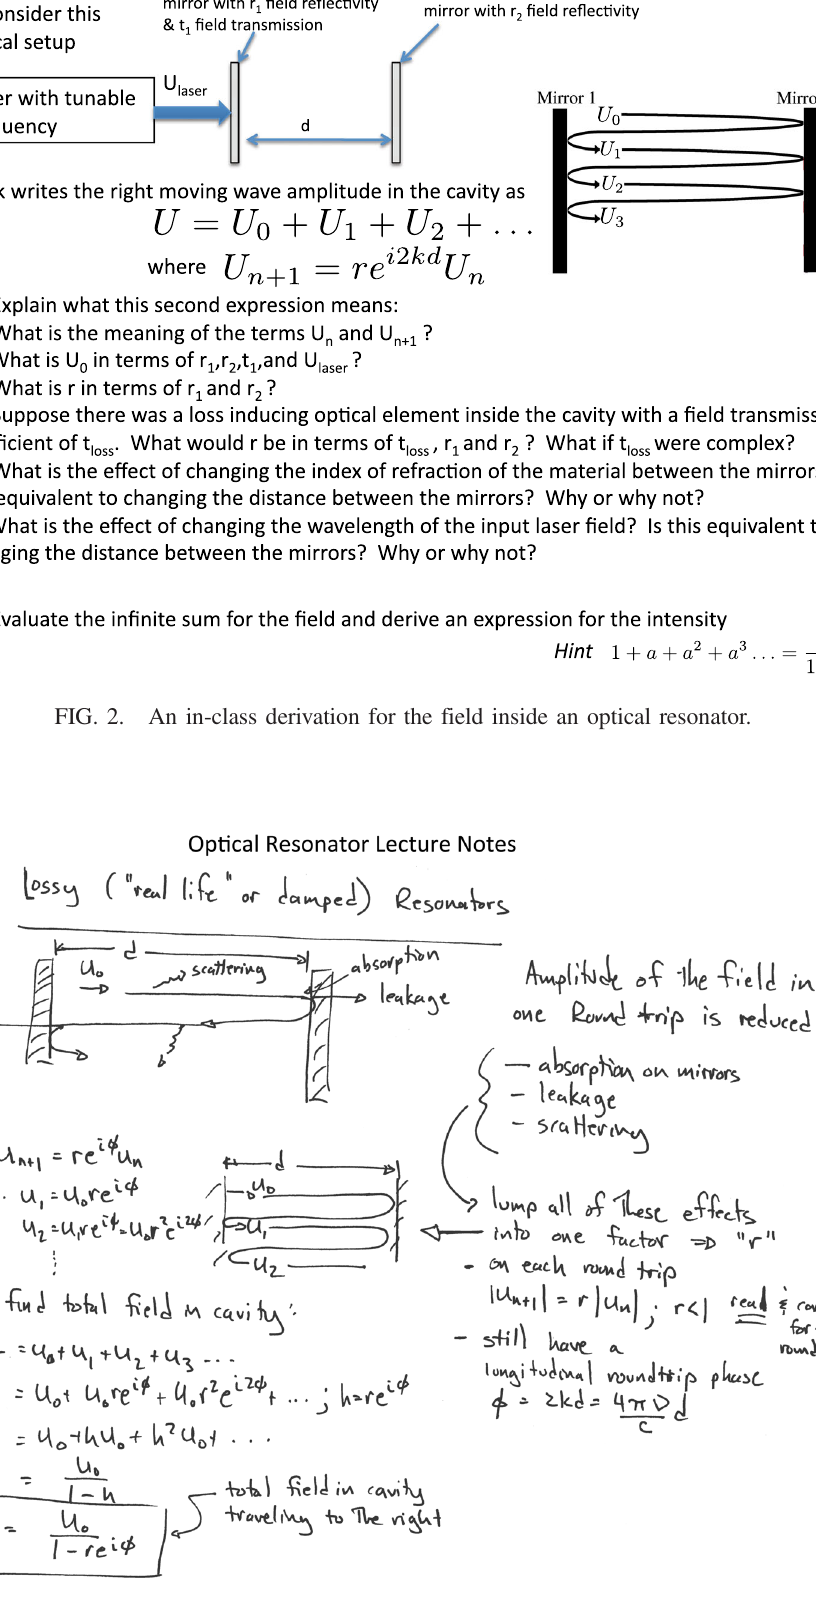
FIG. 3. The corresponding lecture notes for the in-class activities as shown in Fig.